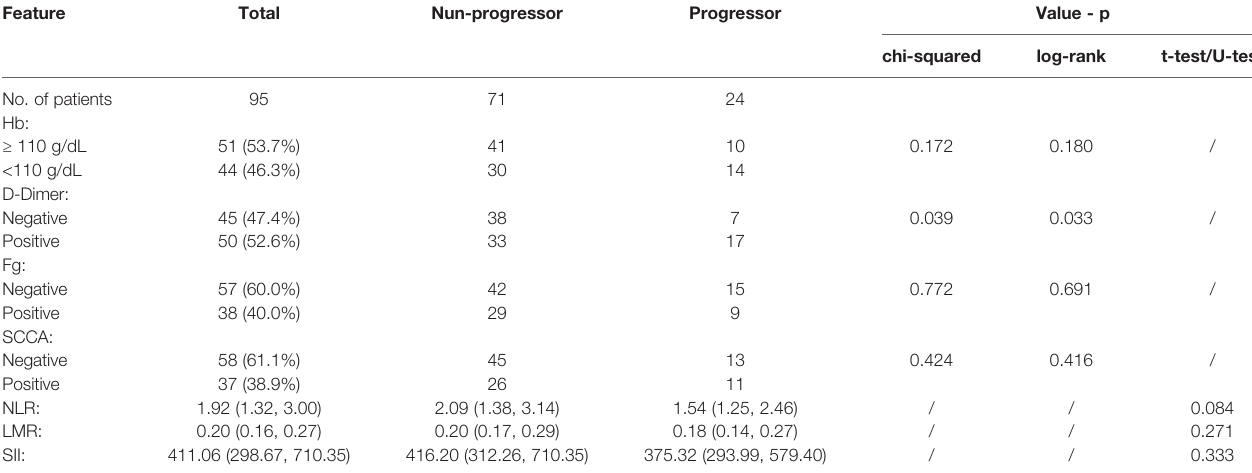
TABLE 1C | Patients ’ hematology-related parameters.